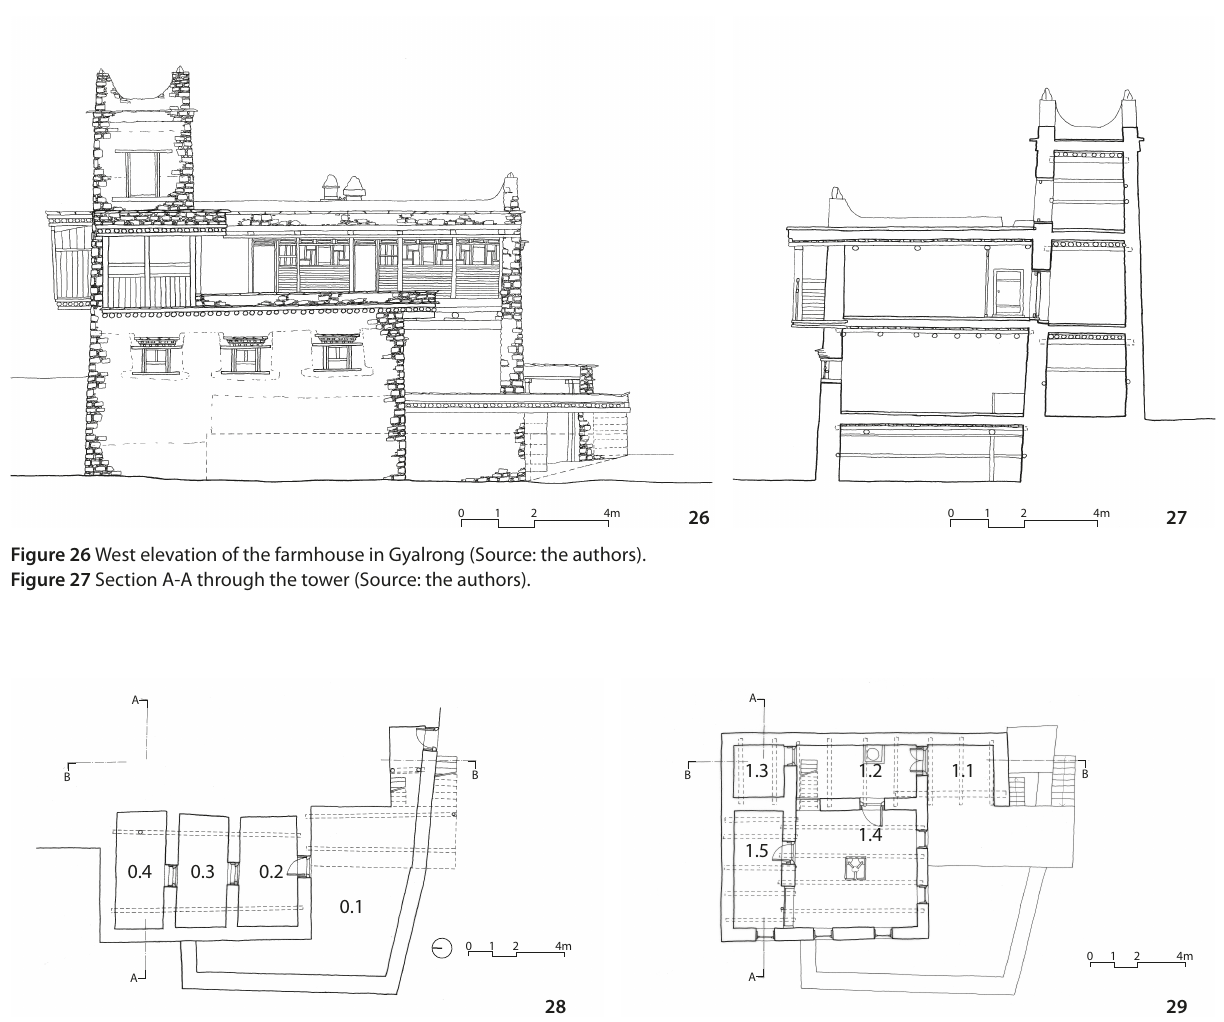
Figure 29 First floor plan of the farmhouse in Gyalrong (Source: the authors).